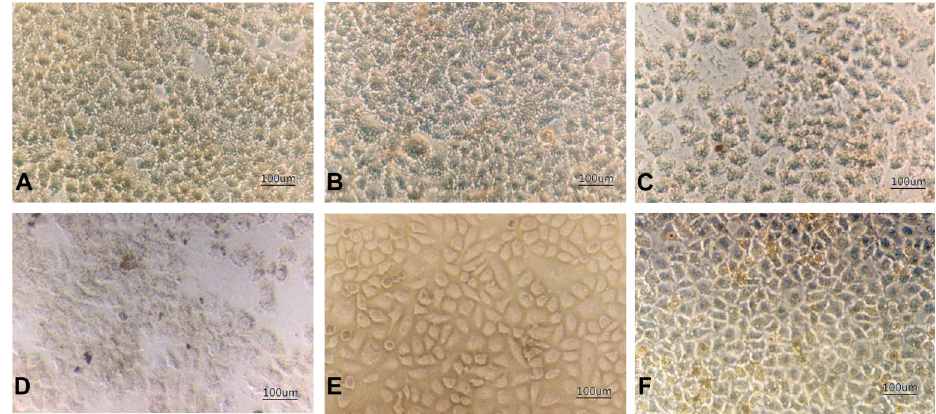
Figure 1. Morphology of SMMC-7721 cells under inverted microscope (100 6 ). A , 2 g/L Fe 2 O 3 MFH group; B , 4 g/L Fe 2 O 3 MFH group; C , 6 g/L